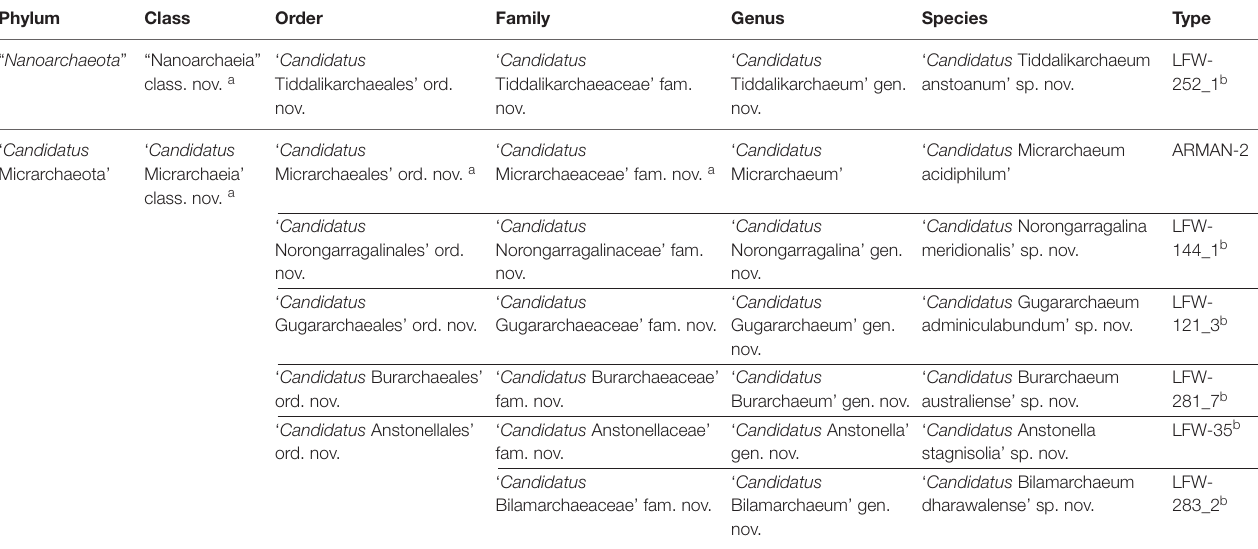
TABLE 1 | Summary of new taxa